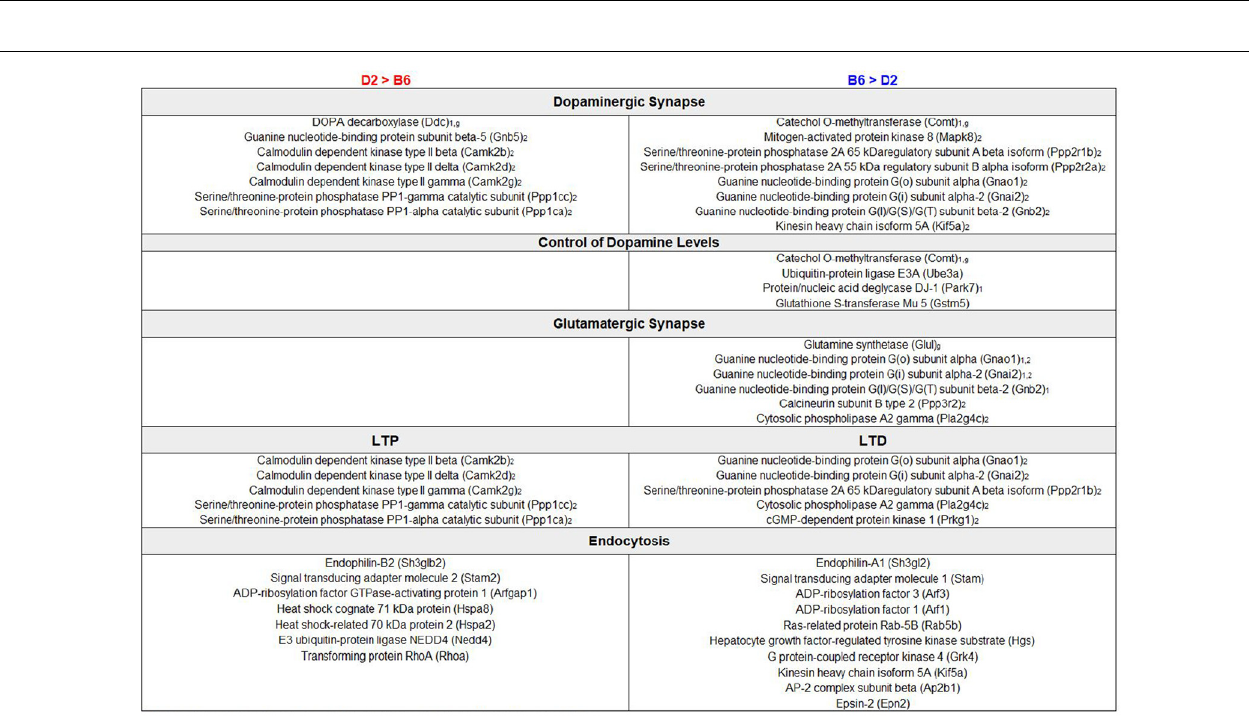
FIGURE 3 | Enrichment analysis of DE proteins. Summary of DE genes by functional categories related to synaptic signaling pathways is shown to the left for higher relative expression in D2 and to the right for higher relative expression in B6. Subscript text represents presynaptic (1), postsynaptic (2), or glial (g) expression. Functional analysis of DE proteins suggests differences in dopaminergic and glutamatergic signaling with a potential impact on learning and behavior.